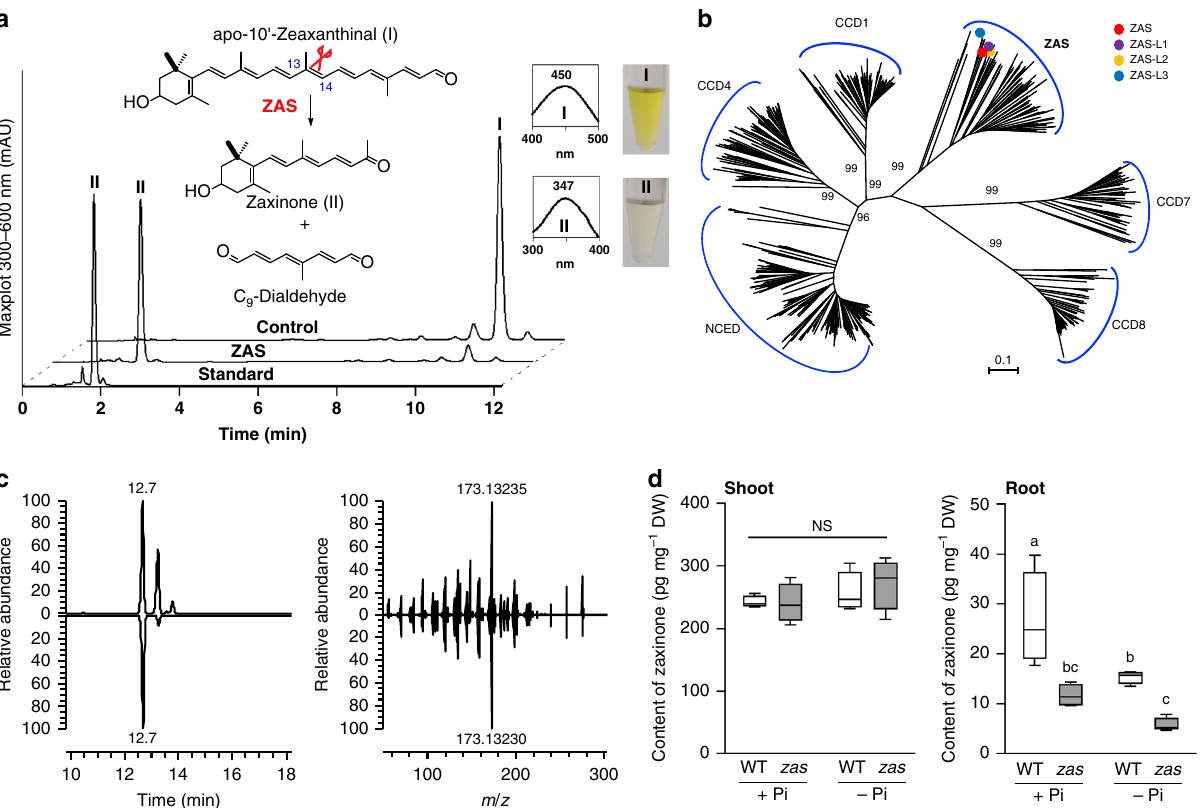
Fig. 1 Characterization of ZAS. a HPLC analyses of in vitro incubation of ZAS with apo-10 ′ -zeaxanthinal (I) yielded zaxinone (II) and a C 9 -dialdehyde. b Neighbour-joining tree of 782 plant CCD orthologues, showing bootstrap values on nodes of NCED, CCD1, CCD4, ZAS, CCD7, and CCD8 clusters only. See details of this tree and its bootstrap values in Supplementary Data 6. Circles represent sequences of ZAS (red) and its orthologues ZAS-L1 -L3. The scale bar indicates an estimated 0.1 change per amino acid. c Identi fi cation of endogenous zaxinone in rice, based on retention time (Left), accurate mass and MS/MS pattern (Right), in comparison to authentic standard. d Quanti fi cation of endogenous zaxinone in wild-type and zas mutant shoots (Left) and roots (Right) under normal ( + Pi) and de fi cient (-Pi) phosphorus supply. Bars represent mean ± SD; n = 4 biological replicates. Statistical analysis was performed by one-way analysis of variance (ANOVA) and Tukey ’ s post hoc test. Different letters denote signi fi cant differences ( P < 0.05),